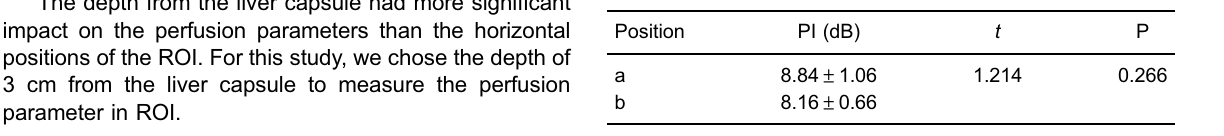
Data are reported as means ± SD. Student ’ s t -test was used for statistical